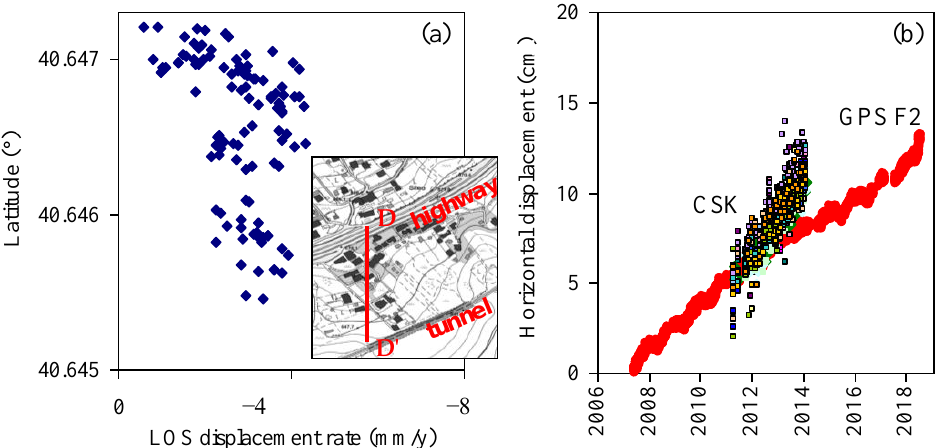
Figure 5. ( a ) Average Line-Of-Sight (LOS) displacement rates in the period May 2011–March 2014 along section DD’; ( b ) comparison with GPS data obtained in the same area (redrawn from [29]).